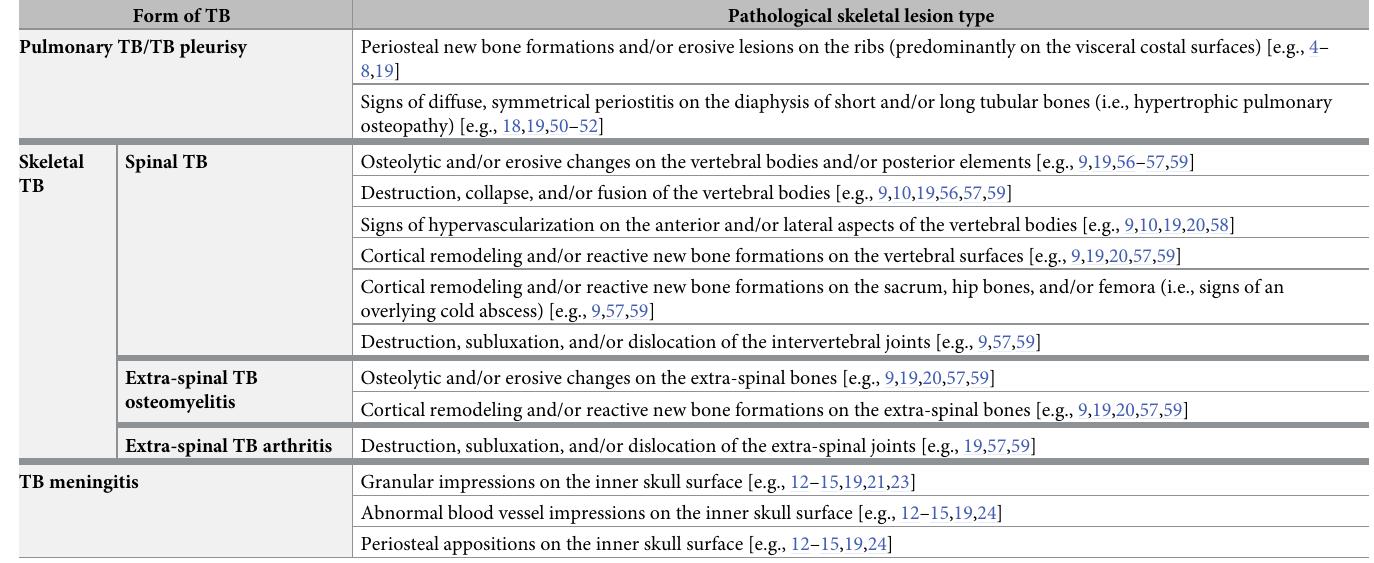
Table 2. List of likely TB-related pathological bony changes other than APDIs that were considered during the evaluation of the 604 selected skeletons from the Terry Collection. Form of TB Pathological skeletal lesion type Pulmonary TB/TB